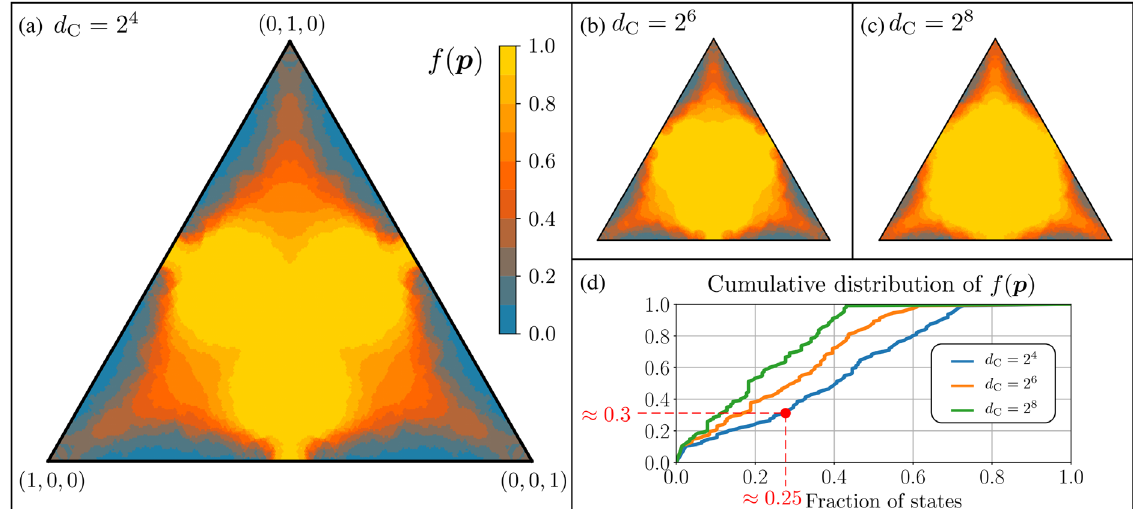
p ; q ; ϵ FIG. 5. Fraction f ð p Þ of all states inside the catalytic activation set D ð p Þ (CAS) for which the probability p that a random succ ð C Þ 0 . 9 . Plots (a) – (c) correspond to random catalysts of dimensions 2 4 , state can be used as a catalyst is larger than the threshold value γ thd ¼ 2 6 , and 2 8 , respectively. Plot (d) illustrates the cumulative distribution of f ð p Þ . As an example, the red point corresponds to the situation 2 4 are used to catalyze possible transformations. These random catalysts are not useful for where random states of dimension d C ¼ roughly 25% of all possible initial states p ; i.e., for each such state, they allow, at most, approximately 30% of all output states q in CAS to be reached with probability equal to or greater than γ . In other words, such random catalysts can be used to reach more than 30% of thld all possible output states q ∈ D ð p Þ , with probability at least γ , for at least 75% of all initial states p . thld